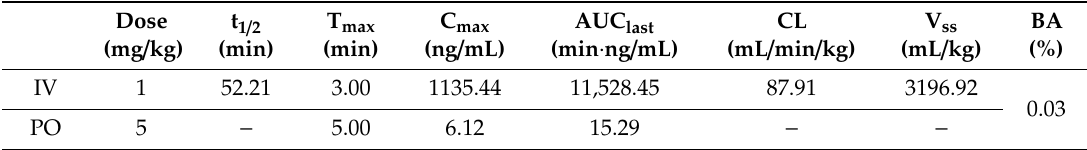
Figure 4. Concentration-time profiles of SCH 58261 in rat following intravenous (IV) administration at 1 mg / kg ( a ) and oral (PO) administration at 5 mg / kg ( b ). Table 5. Pharmacokinetic parameters of SCH 58261 after IV 1 mg / kg administration and PO 5 mg / kg administration in rats.